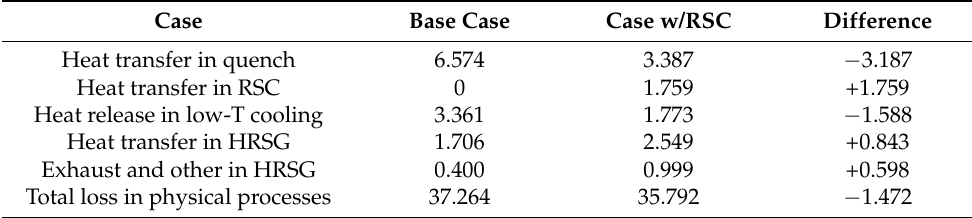
Table 4. Comparison of exergy losses with heat recovery (unit: % of total exergy input).